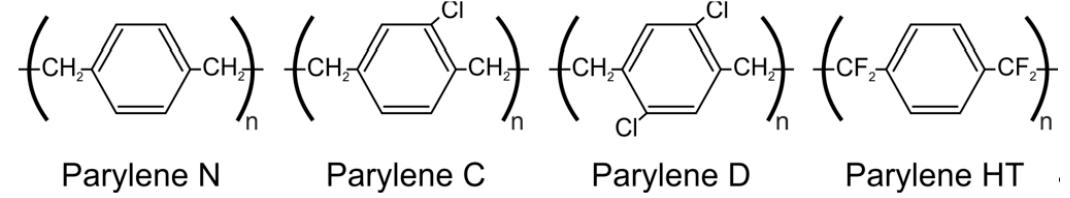
Figure 1. Chemical structure of Parylene types.